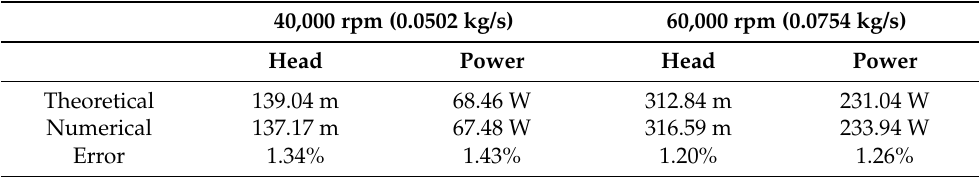
Table 3. Conformance with affinity law at 40,000 and 60,000